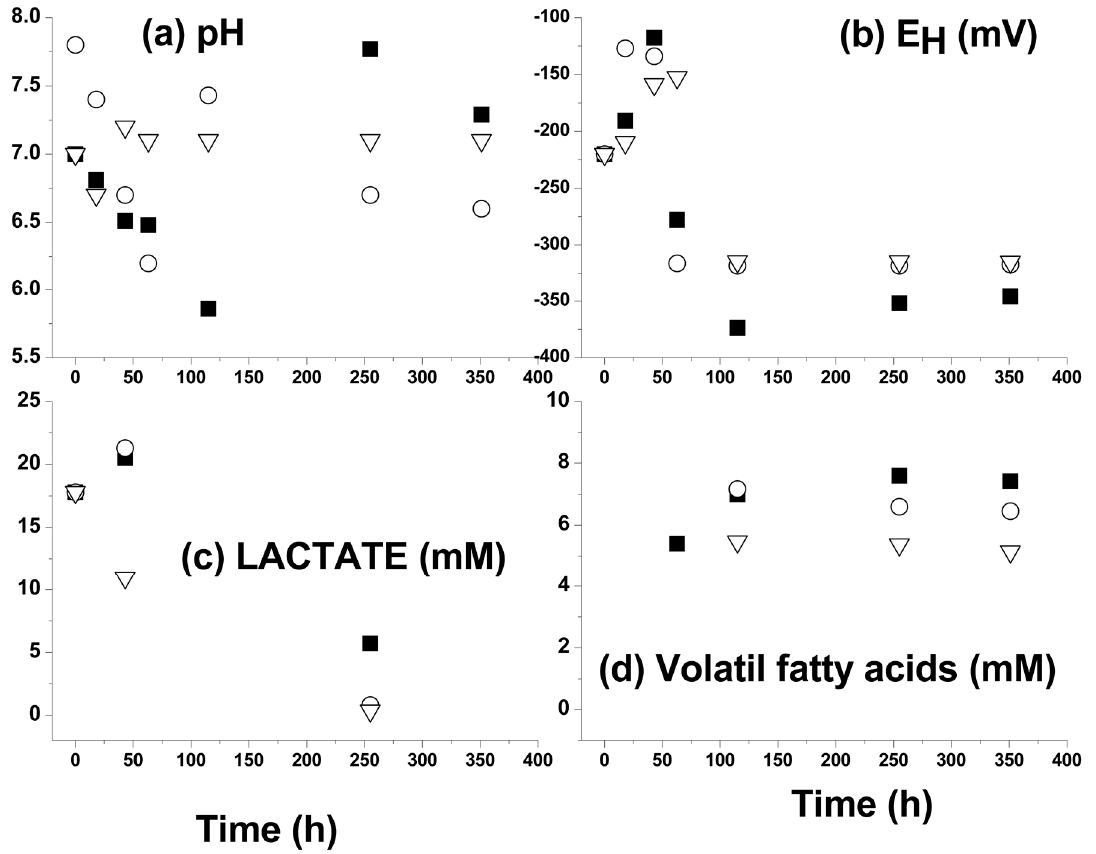
Figure 3. pH, ORP, lactate and acetate evolution during kinetic test of hydrogen sulfide production of sulfidogenic batch reactors inoculated with: ( (cid:4) ) SC469, (